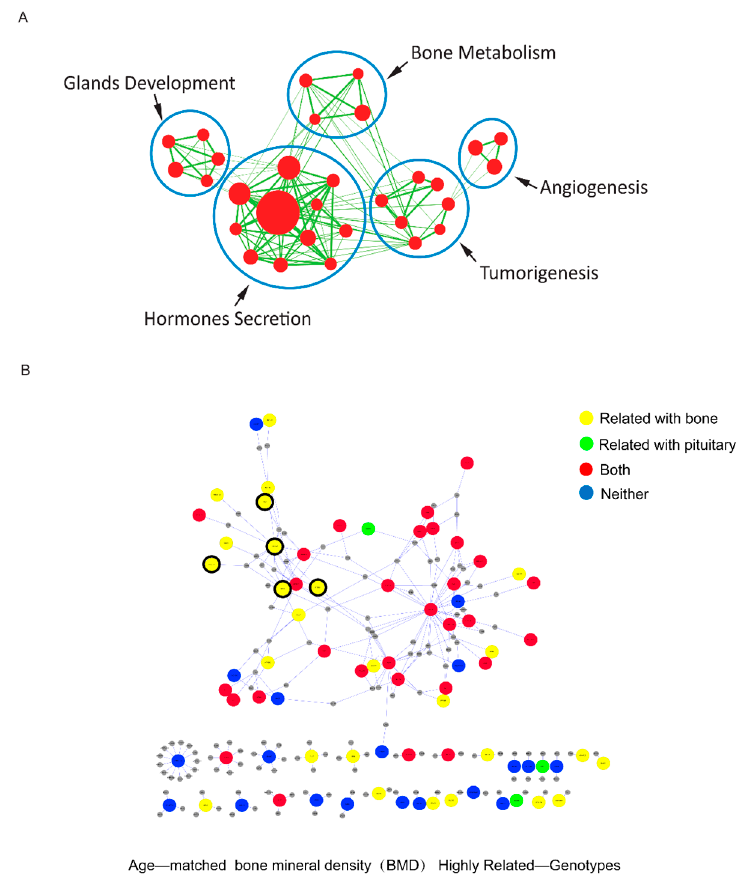
Figure 2. Gene expression profile of ACTH-secreting pituitary adenomas. ( A ) The 423 differentially expressed protein-coding genes in ACTH-secreting pituitary adenoma for the functional enrichment test, GO (Gene Ontology) terms are presented using Cytoscape software (National Institute of General Medical Sciences, USA). Each node is a gene set. The node size is proportional to the number of differentially expressed and interacting genes for this term; the edge thickness represents the number of overlapping genes between sets; ( B ) Literature mining of 138 highly related BMD genes in protein-protein interactions (PPI) connection. Red represents genes reported in the literature for both bone and pituitary adenoma disorders. Yellow and green represent genes reported for bone or pituitary adenomas field, respectively. Blue represents genes not previously reported for bone nor pituitary adenoma fields. The black frame represents the five selected genes.